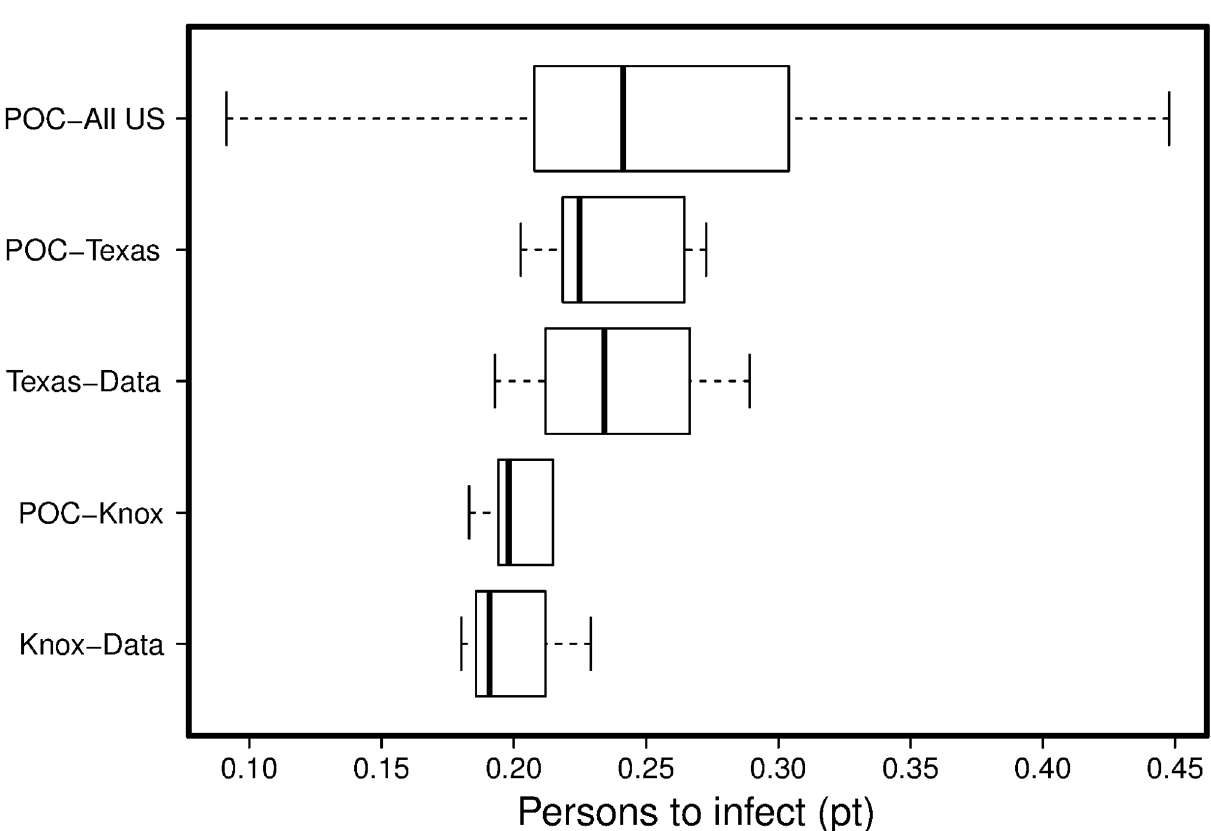
Fig 5. Comparisons of calibrated pt values against distinct datasets.